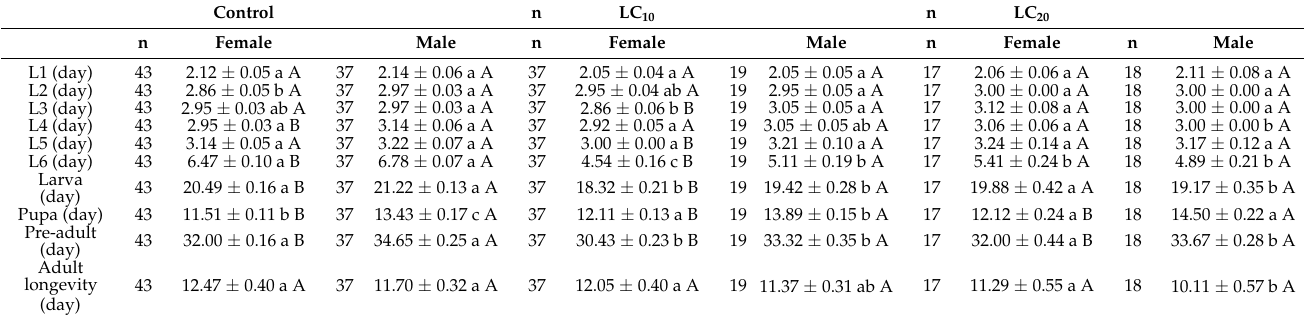
Table 5. Sublethal effects of EMB on the development time of FAW offspring.